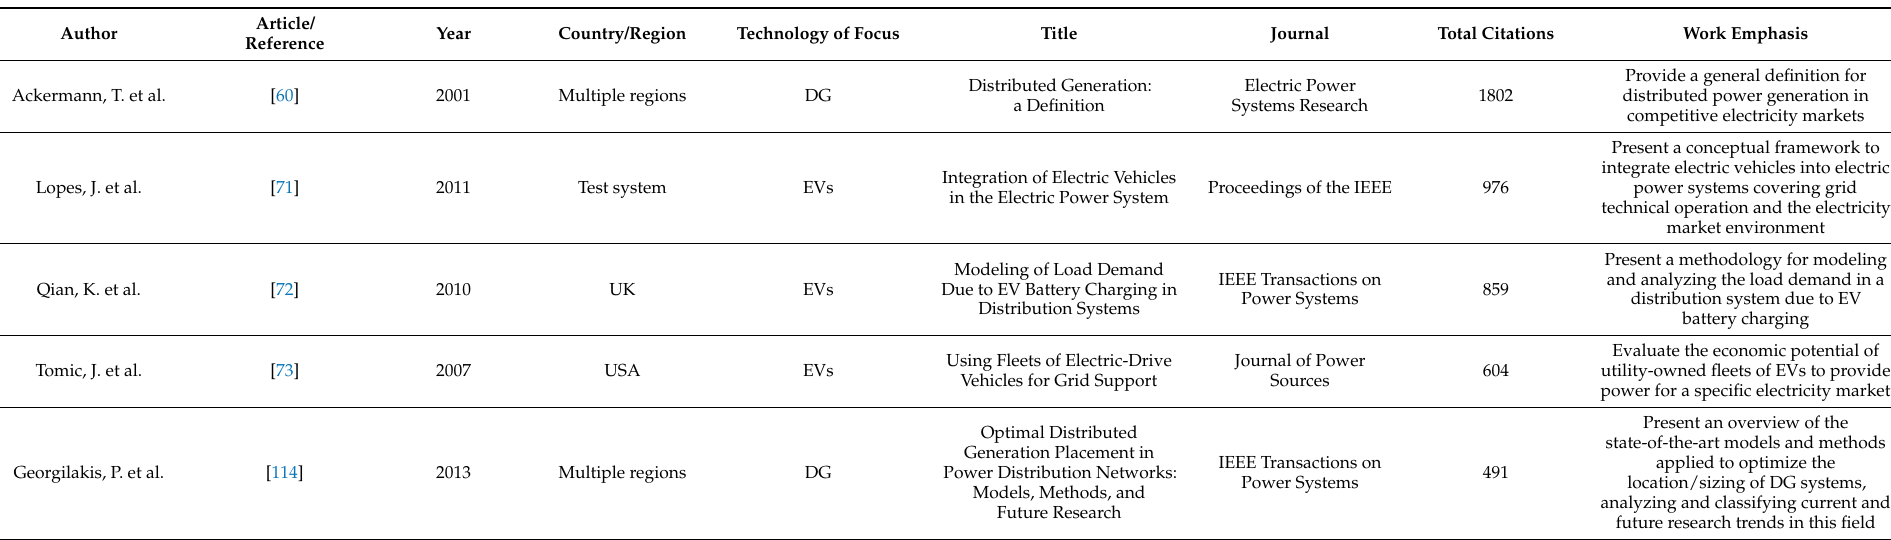
Table A2. Most-cited articles from Sample 1. Source: own study using data from